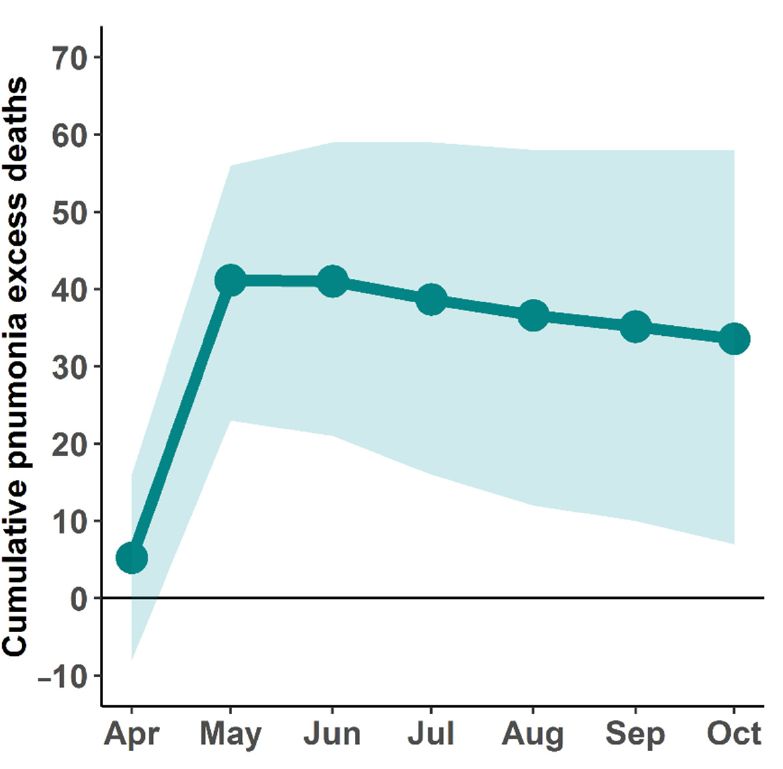
Figure 6. Cumulative pneumonia excess deaths. The line illustrates the cumulative pneumonia excess deaths starting from April to October 2021; the shaded area indicates the 95% CI .